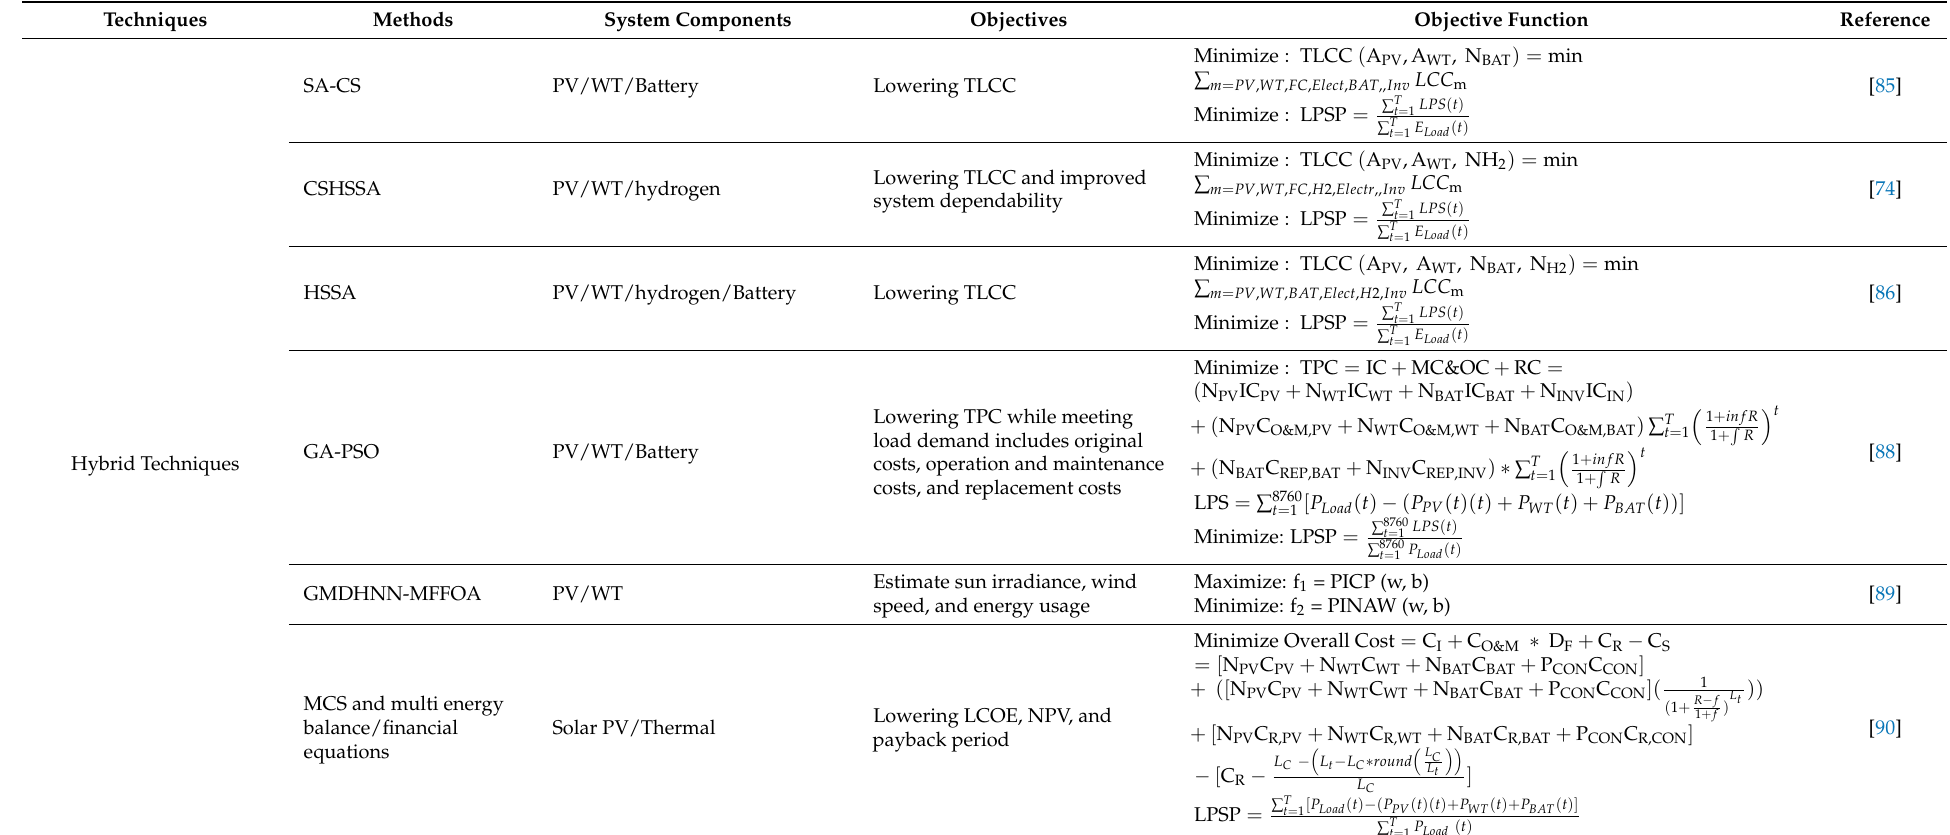
Table 4. A list of hybrid optimization